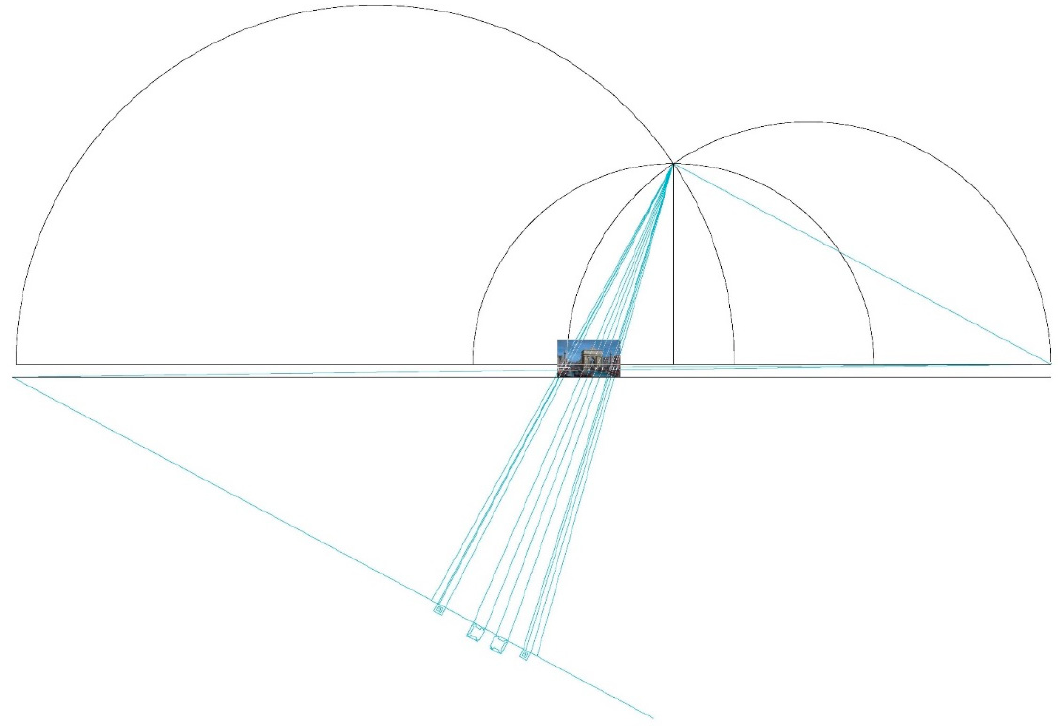
Figure 14. The determination of the position of the Triumphal Apparatus with respect to the city, based on the homology method.